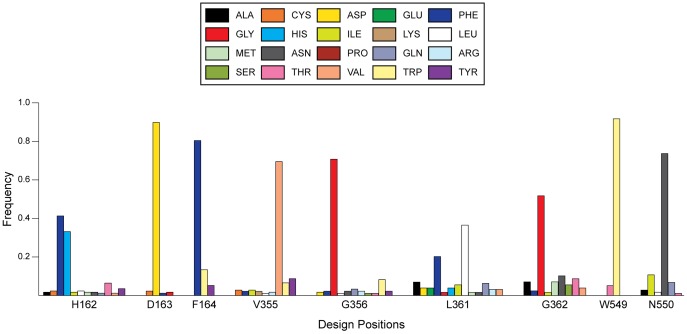
Distribution of amino acids in a sequence alignment for all β-glucuronidases.The sequence alignment was performed over all β-glucuronidases (as identified using BRENDA) using the Clustal-Omega algorithm. 181 unique sequences were used during the alignment. Design position numbers indicate the position within GUS, and the one-letter abbreviation for WT E. coli β-glucuronidase is provided at each position. Only amino acids observed >1% of the time at a given position are shown since smaller bars were difficult to decipher. With the exception of H162, the E.
coli WT residue is the amino acid most frequently observed in the alignment.